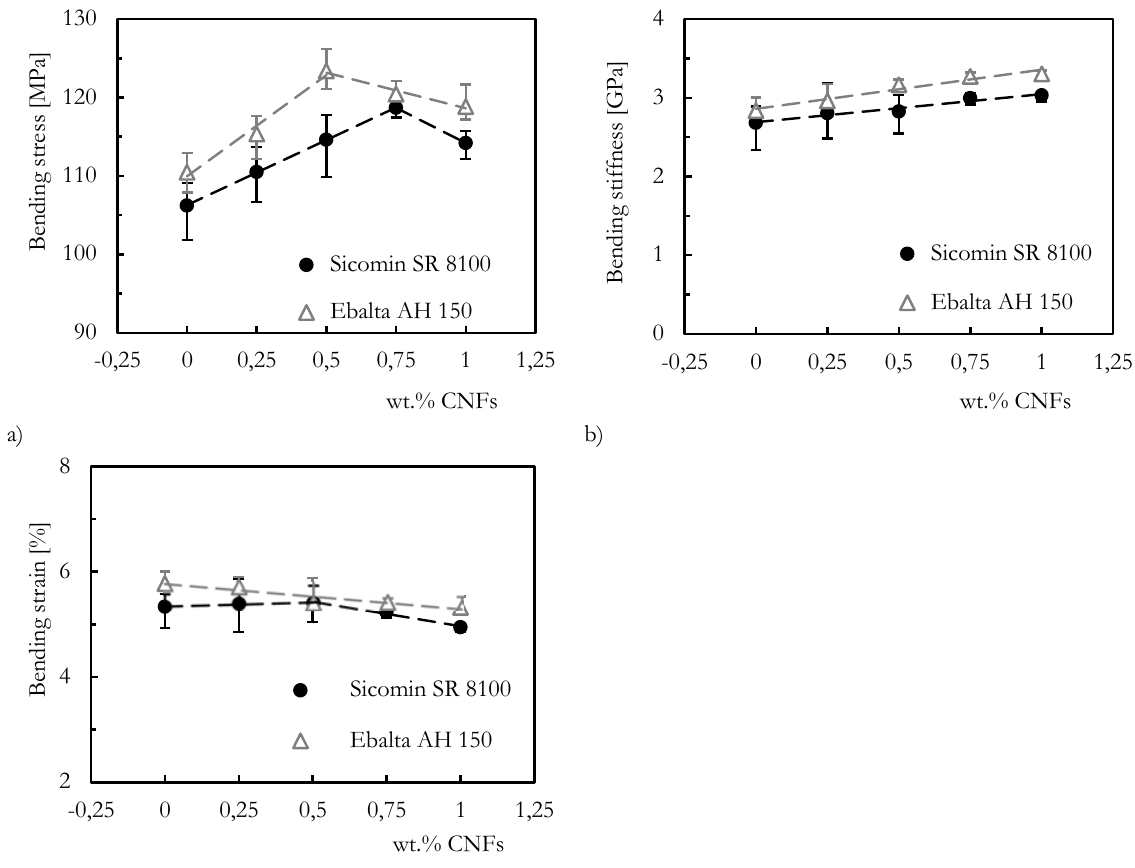
Figure 5: Nano enhanced resin Sicomin SR 8100 and Ebalta AH 150 with different percentages of CNFs: (a) Bending stress; (b) Bending stiffness; (c) Bending